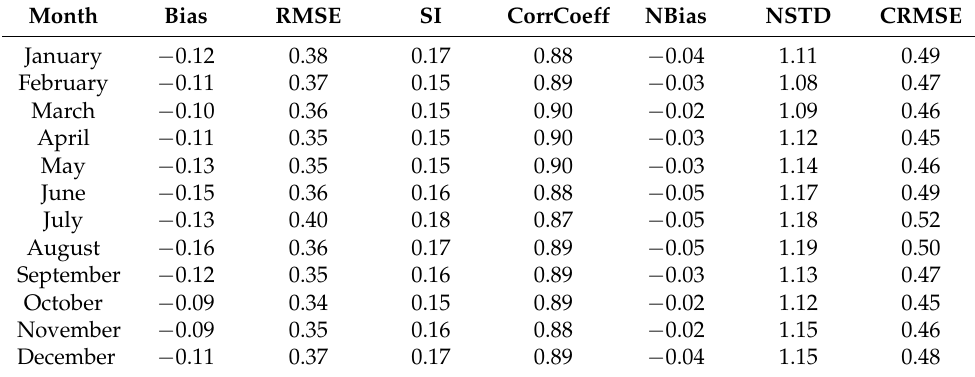
Table 1. Mean monthly variability of error measures between the two reanalyses (significant wave height).